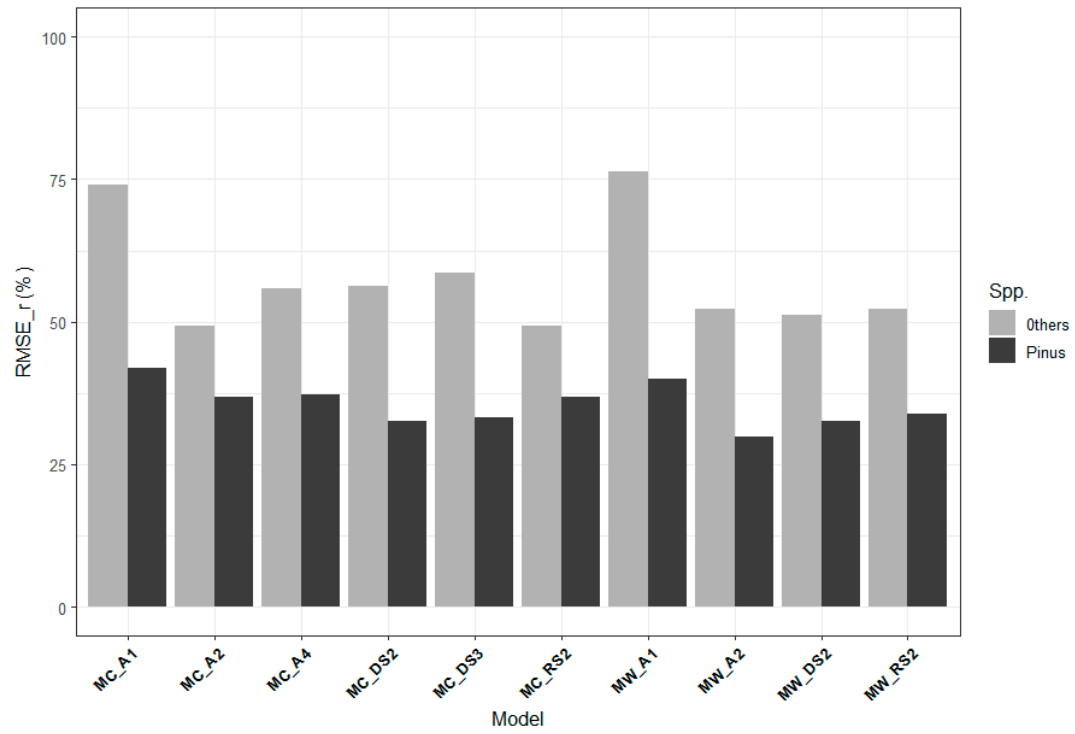
Figure 9. RMSEr of different models with variables extracted from (1) MC and (2) MW approaches, when predicting GSV in Pinus patula (Pine) and other tree species (others).